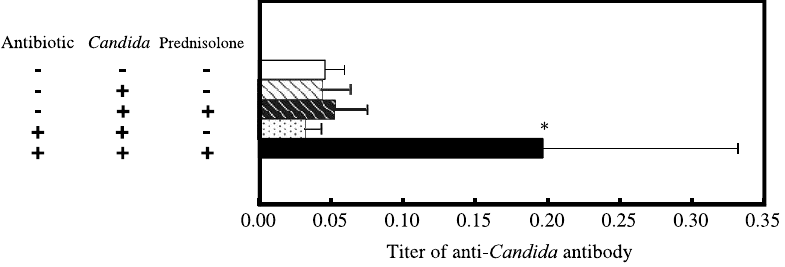
FIG. 5. Enhanced production of anti-Candidaantibody (Ig G) in sera of C.albicans-infected mice treated with prednisolone. Serum levels of antibodies were tested 4 weeks after the Candida infections. Specific IgG of anti-Candida antibody was measured using a specific ELISA as described in Materials and methods. Each value represents the mean 9 / standard error of five mice per group. *p B / 0.05, when compared with the control (normal mouse serum).